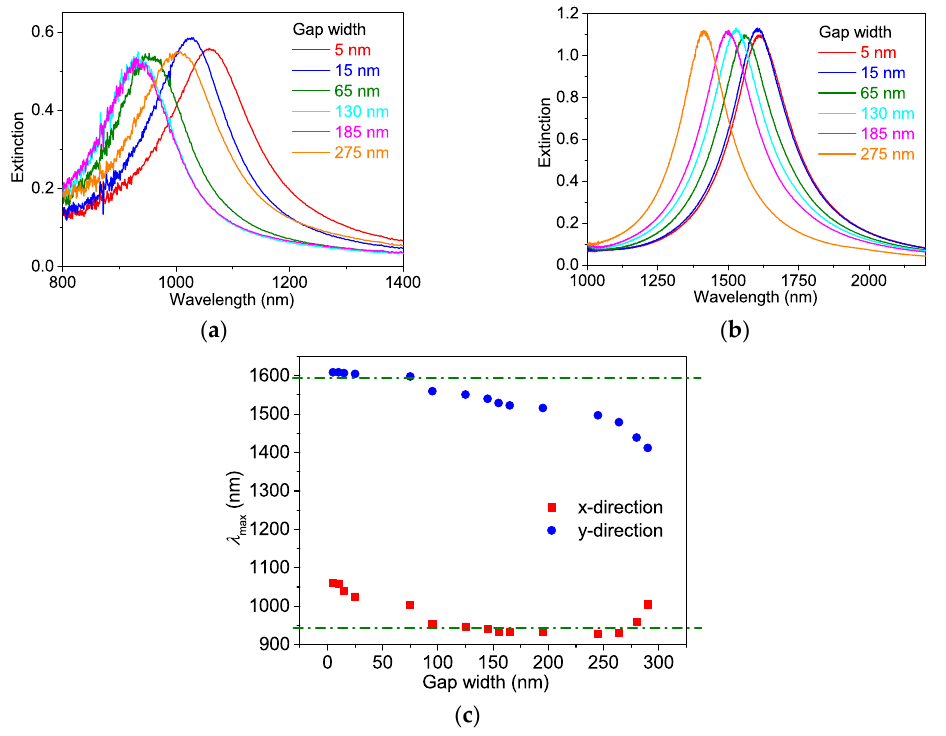
Figure 8. Extinction spectra of the gold curvilinear nanorod dimers with various gap widths (5–275 nm). The directions of linearly polarized light are ( a ) x -, and ( b ) y -directions. ( c ) Plot of peak wavelength position as a function of gap width. The broken green lines show peak wavelengths of the gold curvilinear nanorod monomers (Figure 5b, the arc length was 480 nm).